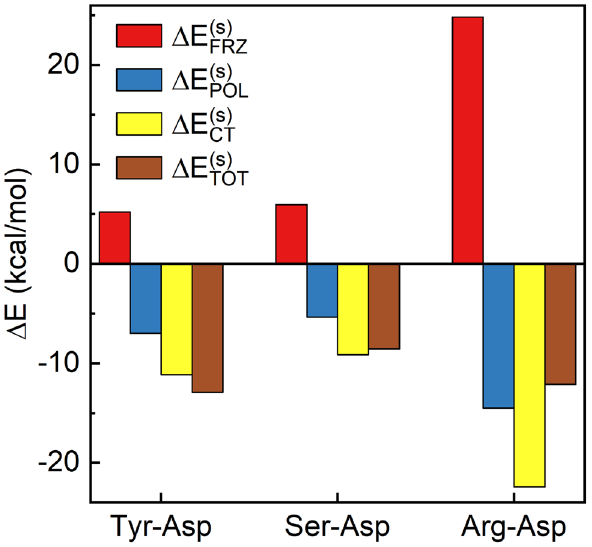
Figure 5. Decomposition of the interaction energies for the Tyr-Asp, Ser-Asp and Arg-Asp hydrogen bonds at R = 2.55 Å. The total interaction energy ( � E ( s ) ( � E POL ) and charge transfer ( �